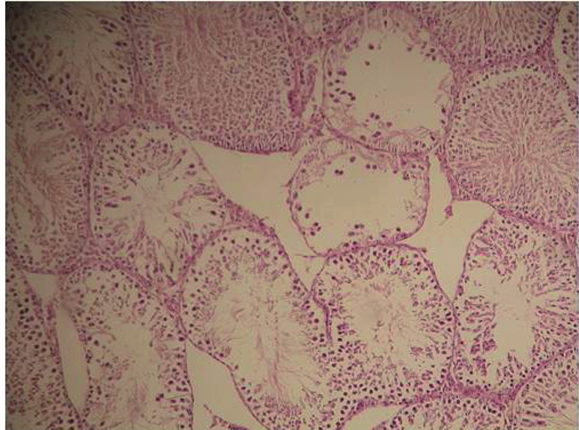
Figure 2 - Light microscopic view of testis tissues from PTX treated group showing normal seminiferous tubule morphology with orderly arrangement of germinal cells. H&E staining; magnification of 10 ×